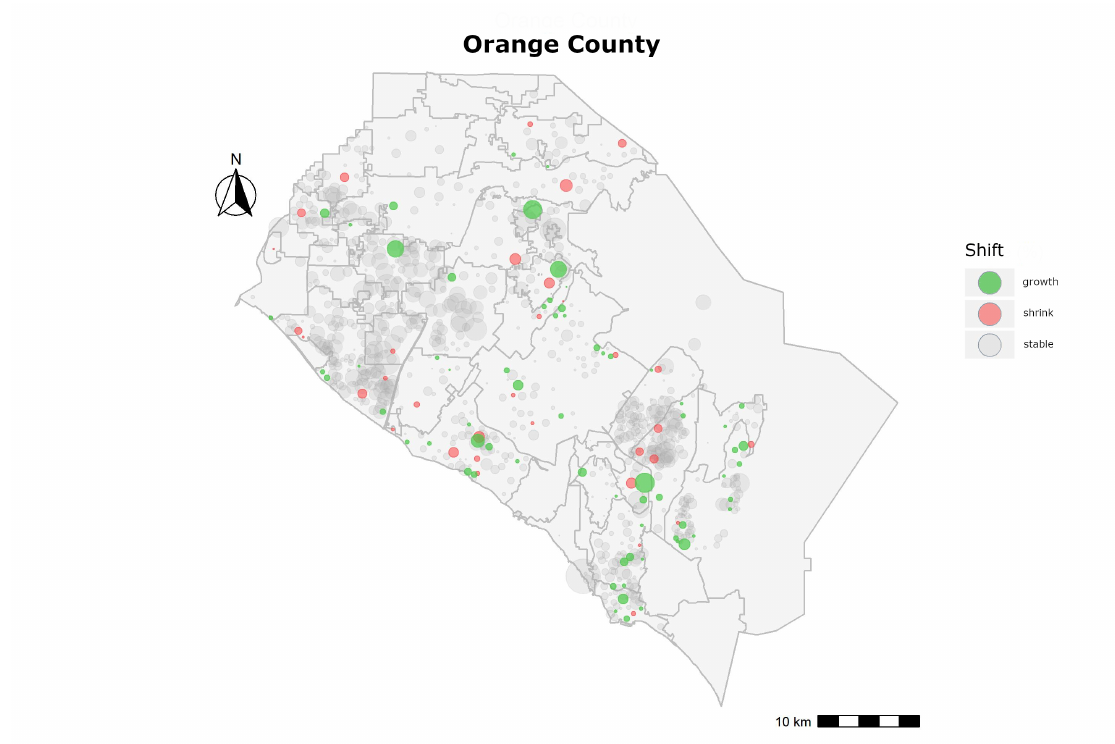
Figure 10. Growing and shrinking neighborhoods in Orange County